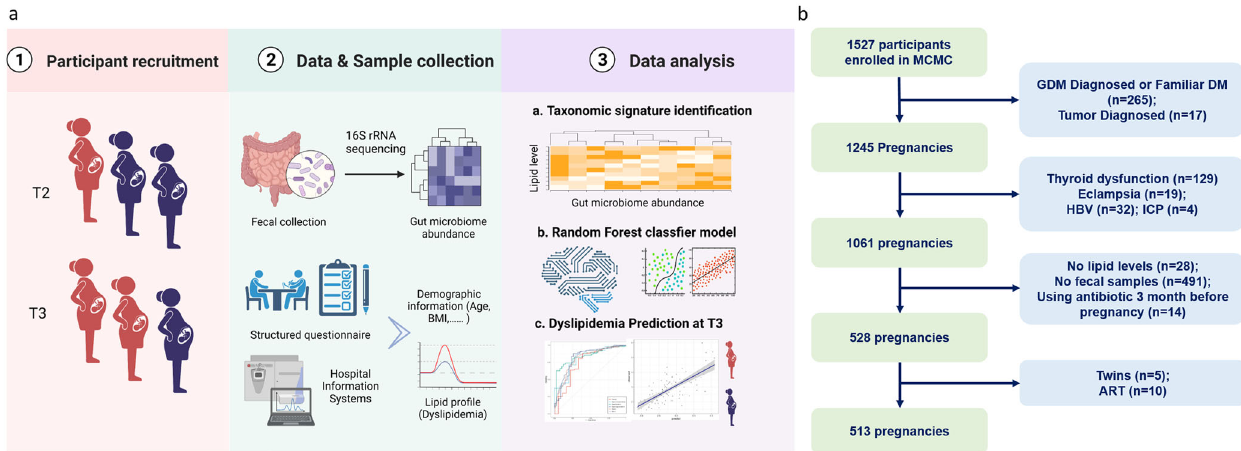
Fig. 1 Study design and fl ow diagram of the population. a Study design (Created with BioRender.com). b Flow diagram of the population included in this